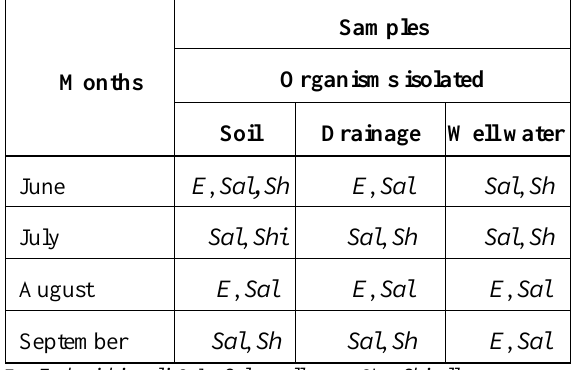
Table 1. Prevalent bacteria from samples.